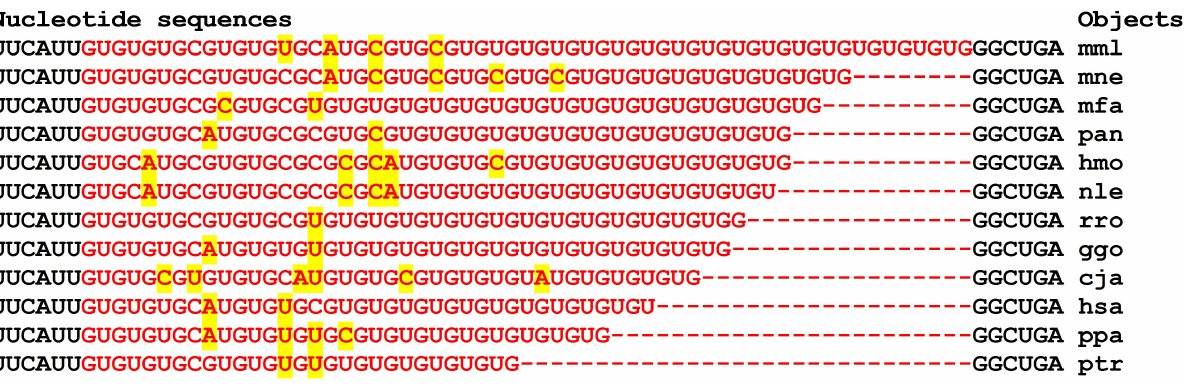
FIGURE 12 | Nucleotide sequences of 3 (cid:48) UTR regions of mRNAs of orthologous GSK3B genes containing clusters of miRNAs BSs.